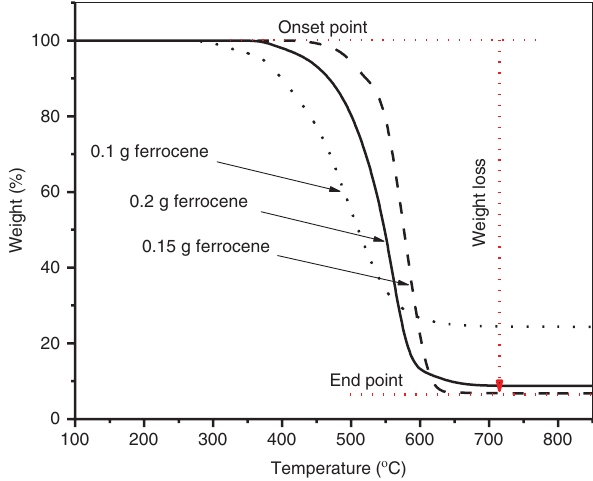
Figure 5: TGA thermograms of MWCNTs grown with 0.1 g, 0.15 g and 0.2 g of ferrocene.